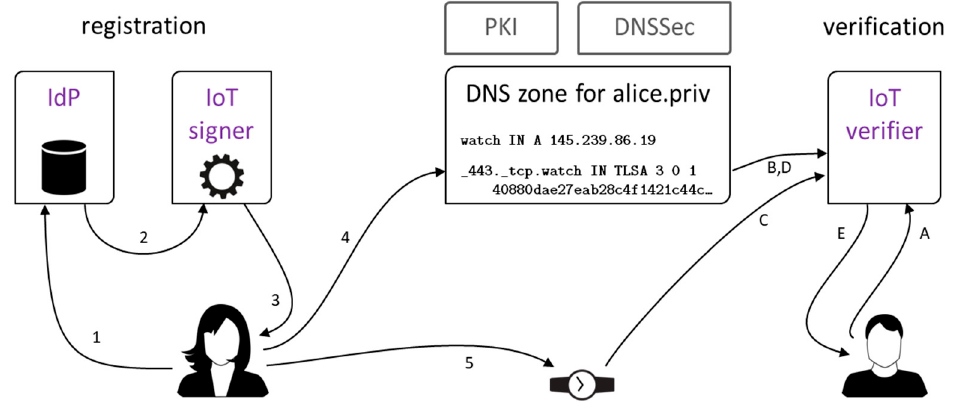
Figure 3. Identity registration scenario ( left ) and identity verification scenario ( right ) for an IoT device. IdP—identity provider.